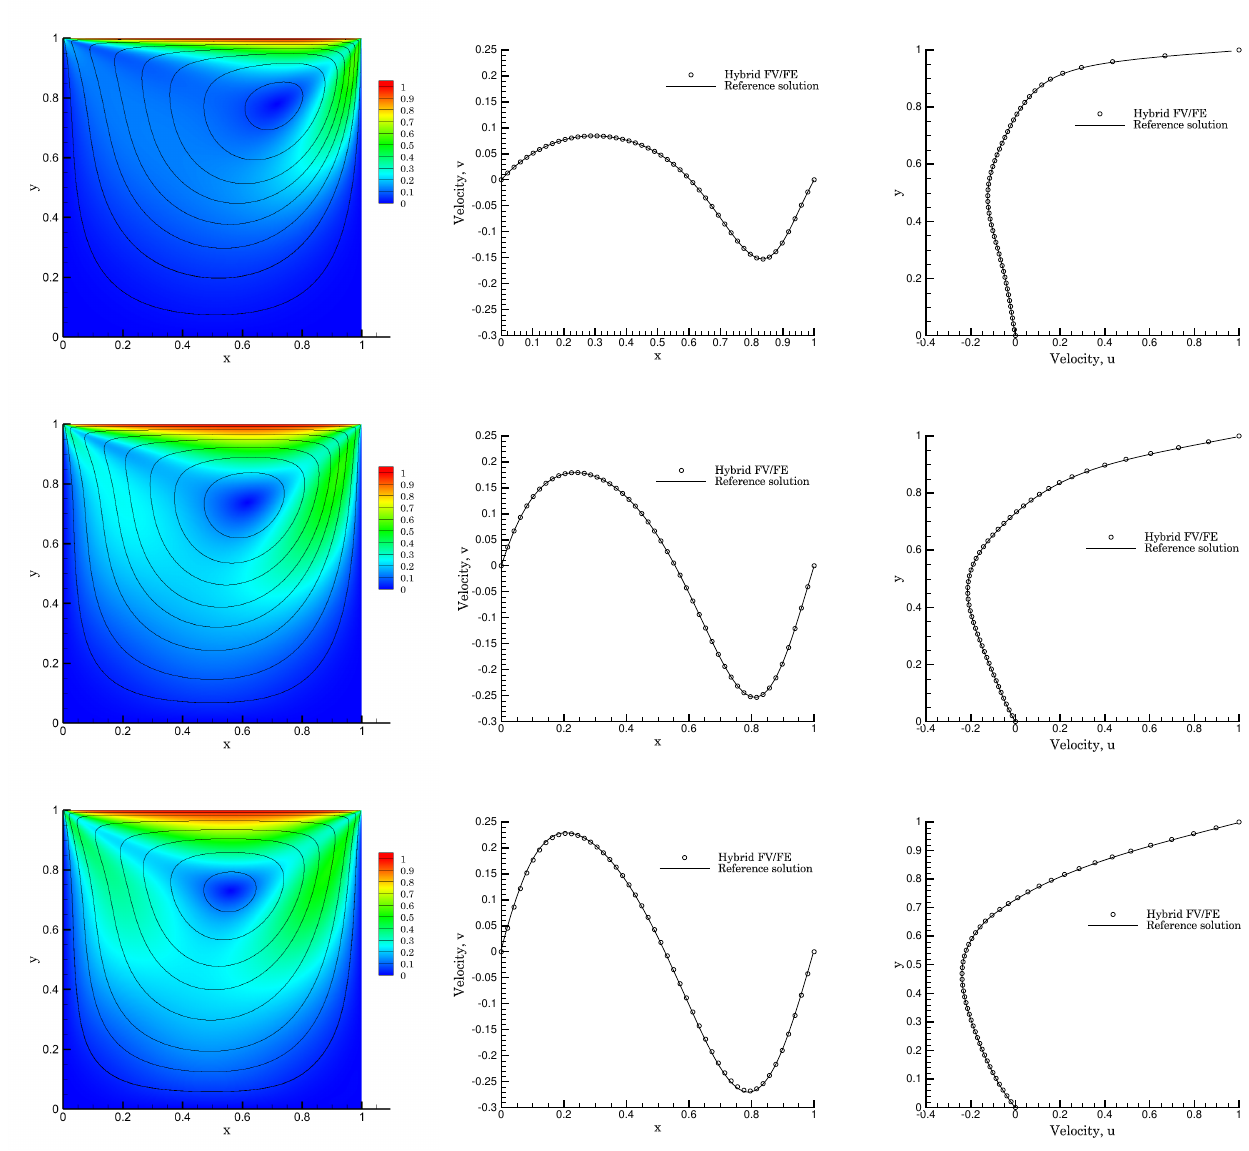
Figure 6. Lid-driven cavity flow without yield stress. Comparison of the numerical results obtained using the hybrid FV/FE method (circles) with the analytical solution of the Herschel–Bulkley model from [89] (solid line). Left: contour of the velocity norm and streamlines. Center and right: 1D cuts of the velocity field in x = 0.5 and y = 0.5 and the reference solution considering the power-law indexes n = 0.5 ( top ), n = 1 ( middle ) and n = 1.5 ( bottom ). The consistency parameter is k = 10 − 2 and the yield stress equals